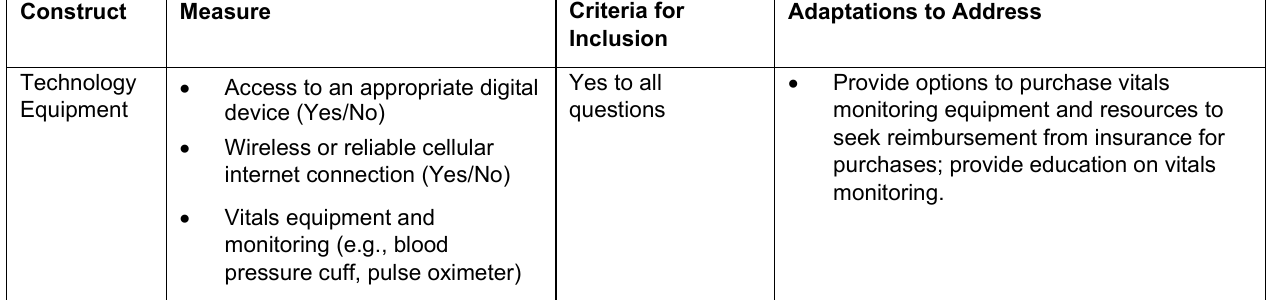
Table 2 General Outline of an Eligibility Screen and Needs Assessment for Group Telerehabilitation